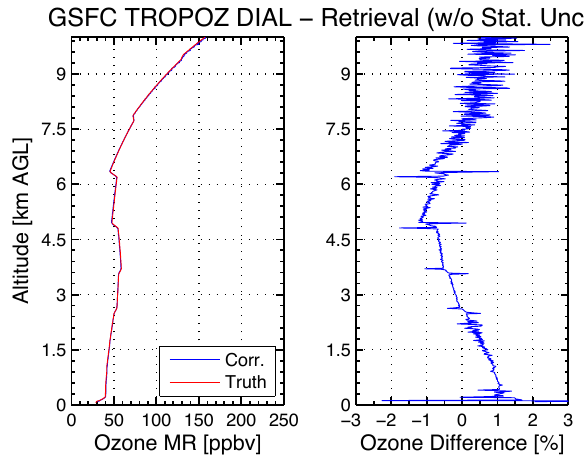
Figure 5. The left panel shows the retrieved ozone mixing ratios from the saturation corrected and uncorrected TROPOZ ozone pro- files as compared to the known ozone profile used in the simulated lidar return signal.The right panel shows the percent difference from the known profile and retrieved profile.